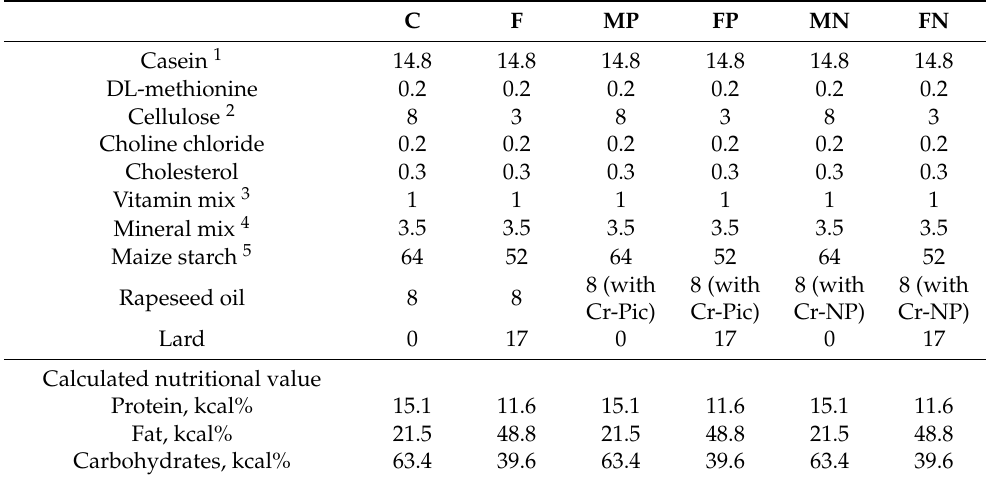
Table 5. Diets used in the experiment (%).